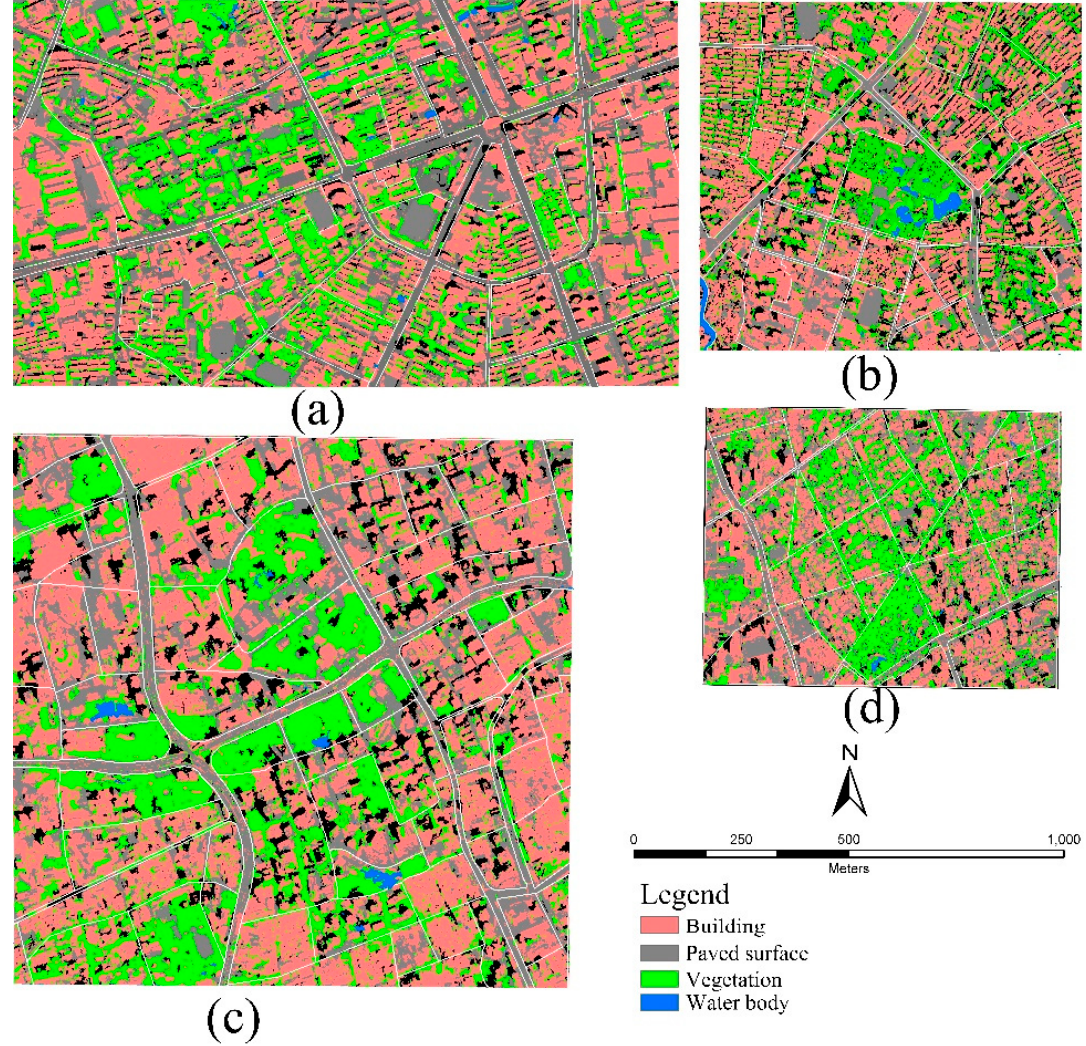
Figure 3. Parcel-level land use/land cover (LULC) components at four UFZs. Note: The labels (a), (b), (c), and (d) denote the four UFZs known as Wujiaochang, PeacePark, UrbanCore, and Xujiahui, respectively. The white polygons denote the land parcels’ boundaries. The black spots denote the pixels shaded by the buildings and were removed to avoid the biased result of thermal analysis.